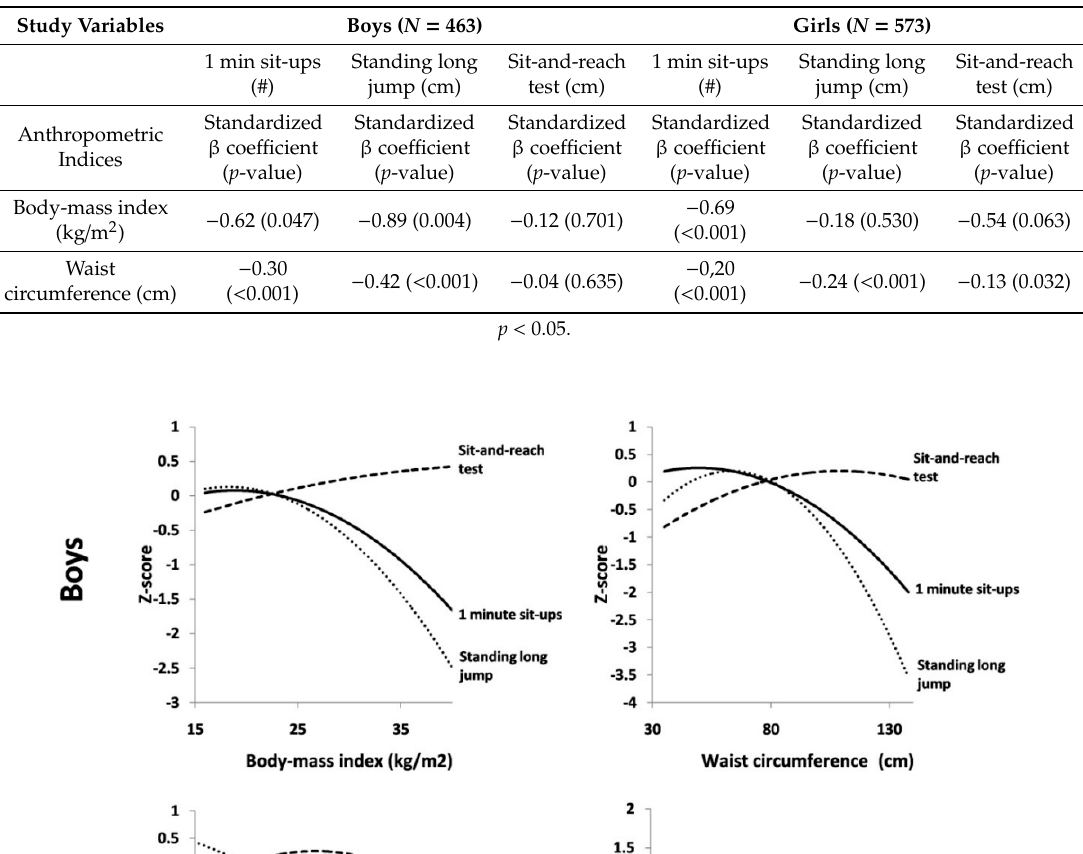
Table 2. Quadratic regression associations between anthropometric indices and physical fitness tests in boys and girls, Croatia (2019).